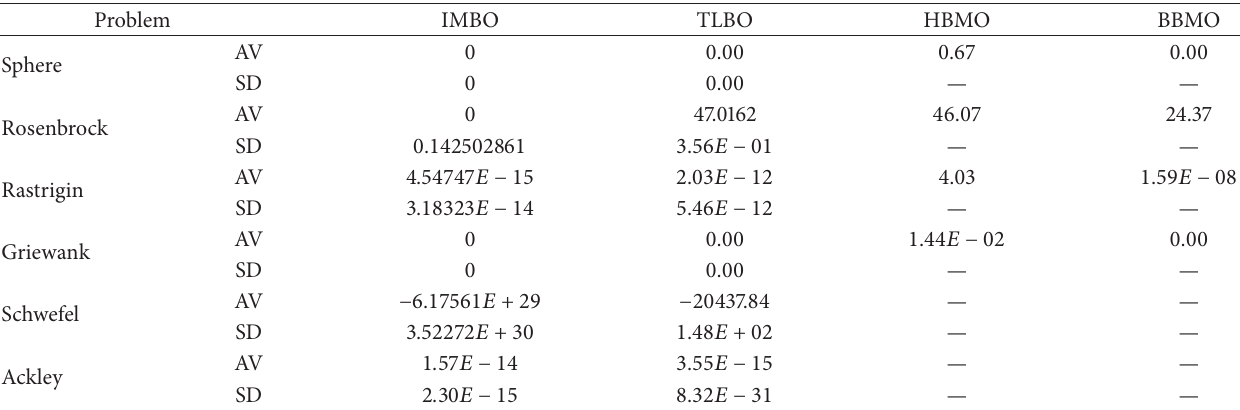
Table 9: The mean solutions obtained by the TLBO, HBMO, BBMO, and IMBO algorithms for 6 test functions over 30 independent runs and total success numbers of algorithms. Genotype size: 50; (—): not available value, SD: standard deviation, AV: global minimum